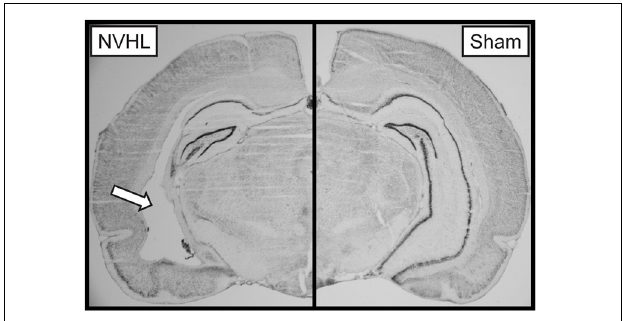
FIGURE 2 | Representative image of a NVHL (left) and sham (right) brain. The arrow points to the NVHL lesion in the ventral